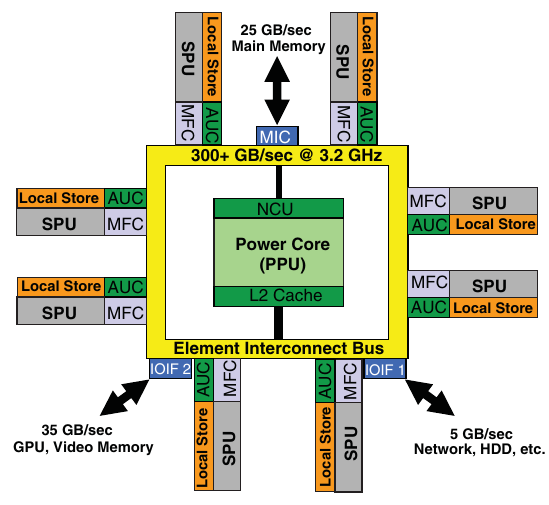
Fig. 1. Cell Broad Band Engine. Cell Broadband Engine has one control-plane specialized processor (PPU), which can be described as a power core and eight xz data-plane specialized processors (SPUs) on the same